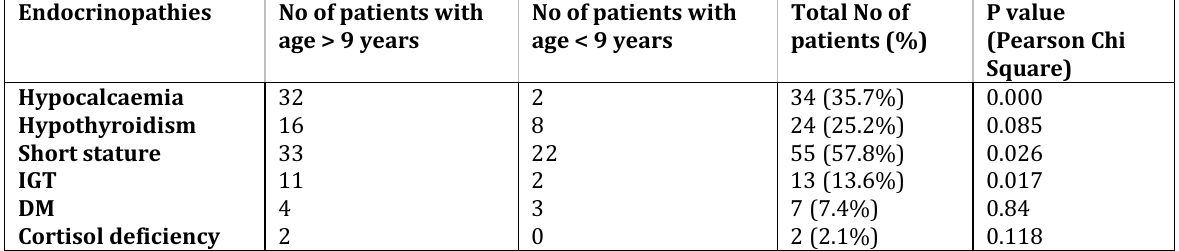
Table 3 - Comparison of prevalence of endocrinopathies between those who are above 9 years and below 9 years of age among thalassemia patients attending teaching hospital Batticaloa, Sri Lanka.